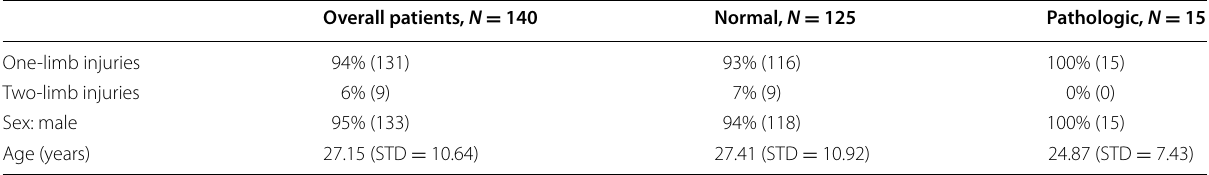
Table 1 Population